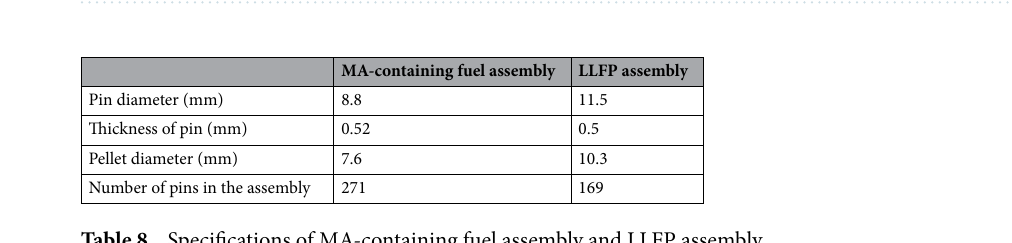
Table 7. Specification of large-scale fast breeder reactors for MA and LLFP transmutation.